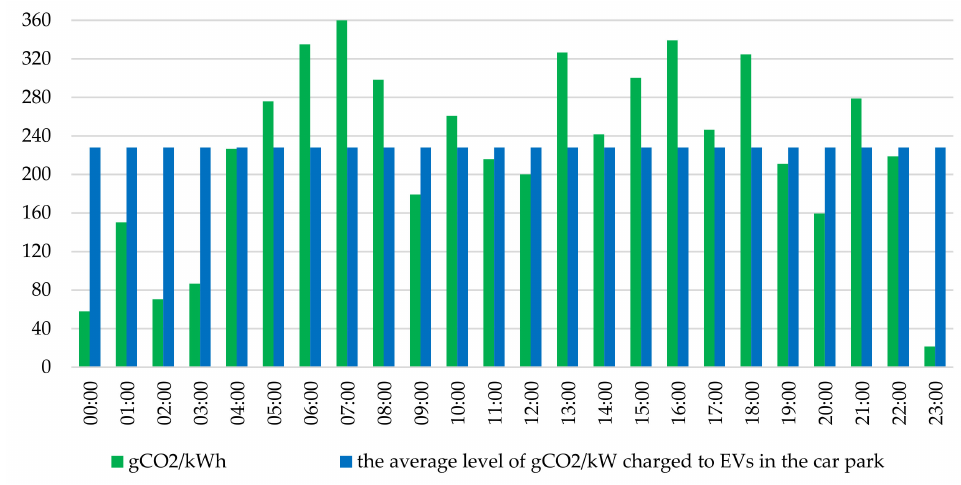
Figure 10. Emissions correlated with each kWh charge to EVs at the car